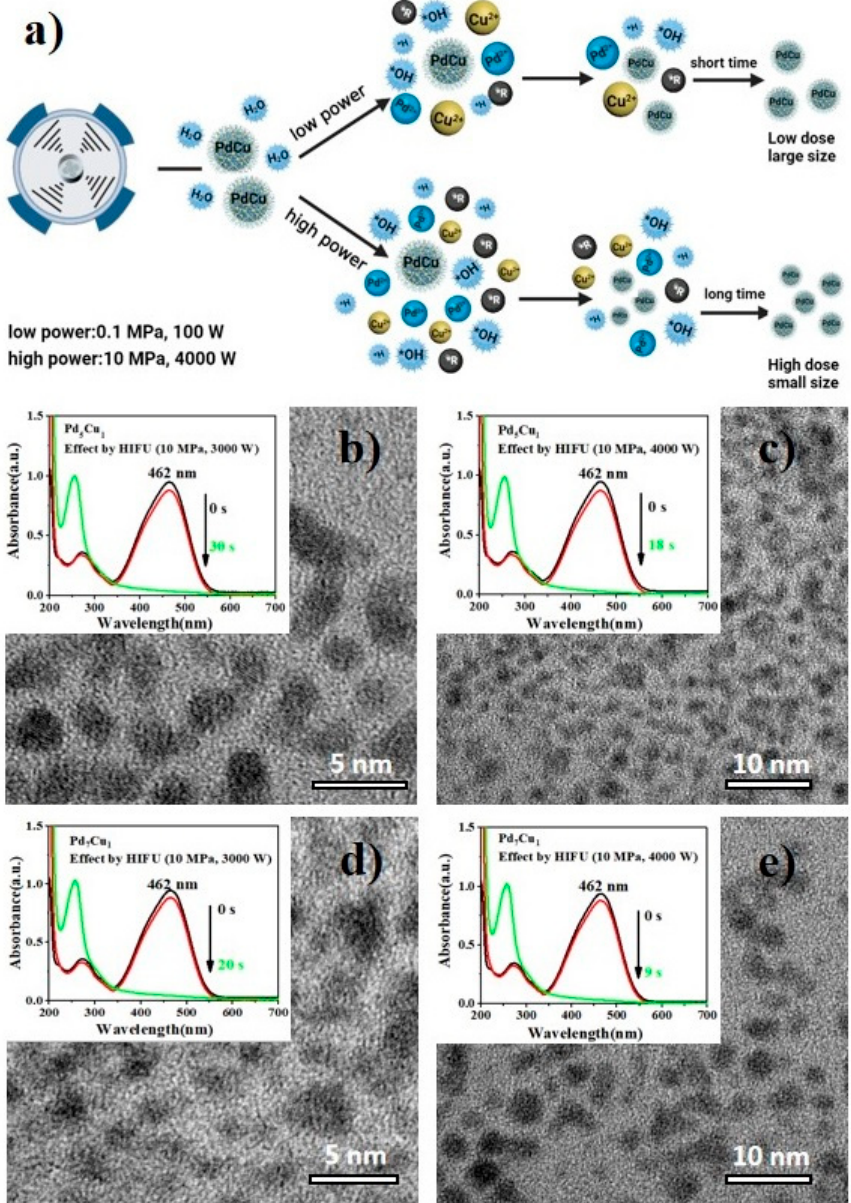
Figure 8. ( a ) Mechanism diagram of Pd-Cu alloy NPs effected by High intensity focused ultrasound. ( b , c ) TEM and UV- vis absorbance spectra of degradation of 0.06 mM MO by NaBH 4 in the presence of Pd 5 Cu 1 alloy NPs effected by ultrasound field (10 MPa, 3000 W and 10 MPa, 4000 W); ( d , e ) TEM and UV- vis absorbance spectra of degradation of 0.06 mM MO by NaBH 4 in the presence of Pd 7 Cu 1 alloy NPs effected by ultrasound field (10 MPa, 3000 W and 10 MPa, 4000 W). The reaction times were 80 s, 60 s, respectively. The size of particles decreased obvi- ously, but catalytic performance was enhanced. It meant the physical treatment can pro- mote the crystalline converting in growth process. The smaller sized Pd-Cu alloy NPs in- crease the contact with dye molecules, accelerated the degradation completely. The inset image in Figure 7b–e, it showed two kinds of Pd-Cu alloy NPs (Pd 5 Cu 1 , Pd 7 Cu 1 ), the per- formance in catalytic MO molecule while using high intensity focused ultrasound treated Pd-Cu NPs. According to details, the relative degradation reaction just needed 30 s, 18 s, 20 s, 9 s, respectively. The apparent rate constants (K app ) for all samples were presented in